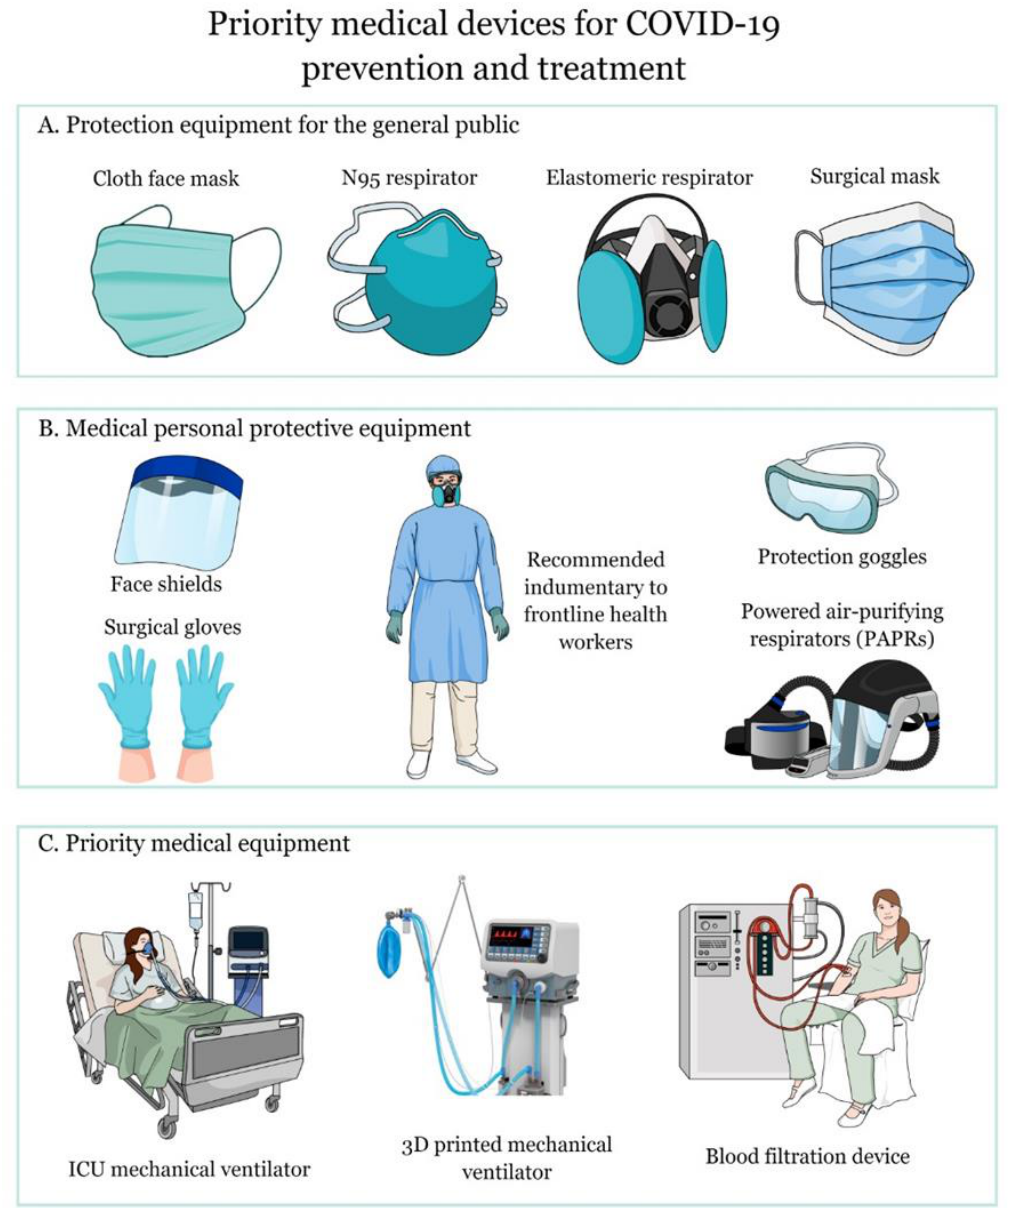
Figure 3. Priority medical devices for COVID-19 prevention and treatment. ( A ) Face masks are the most used protection equipment in the general population, but for frontline health workers, special filter masks should be used to prevent infection. ( B ) Face shields, gloves, filter respirators, plastic boots, protection goggles, and hospital gowns are recommended for medical sta ff members. ( C ) Mechanical ventilators are priority devices for the intensive care unit, but other devices, such as blood filtration devices, have been approved by the U.S. Food and Drug Administration (FDA) for emergency use, to avoid complications due to an excess of cytokines in patients with an overloaded immune